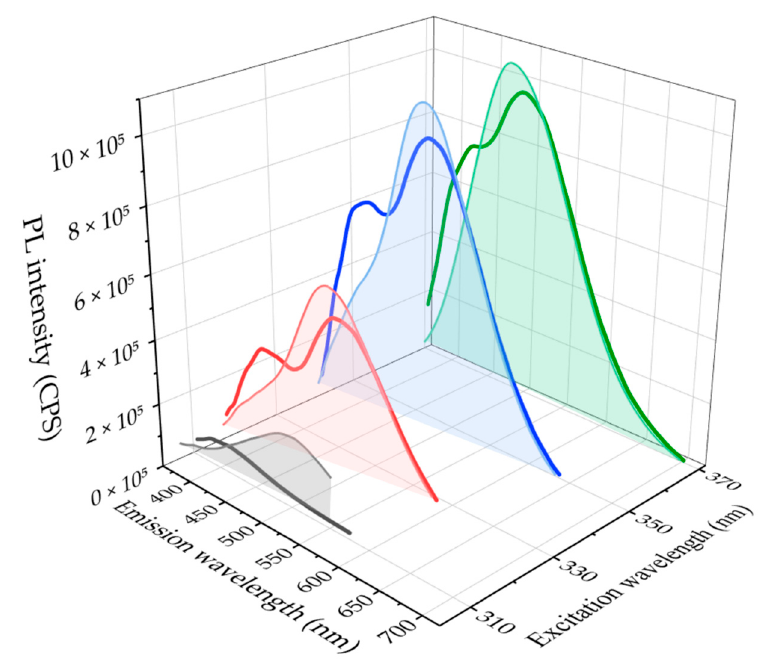
Figure 2. Comparison of the PL spectra of a purified O-CD sample re-dispersed in CHCl 3 (filled area) and the respective supernatant (acetone based) after the purification procedure (thick lines) recorded at different excitation wavelengths.